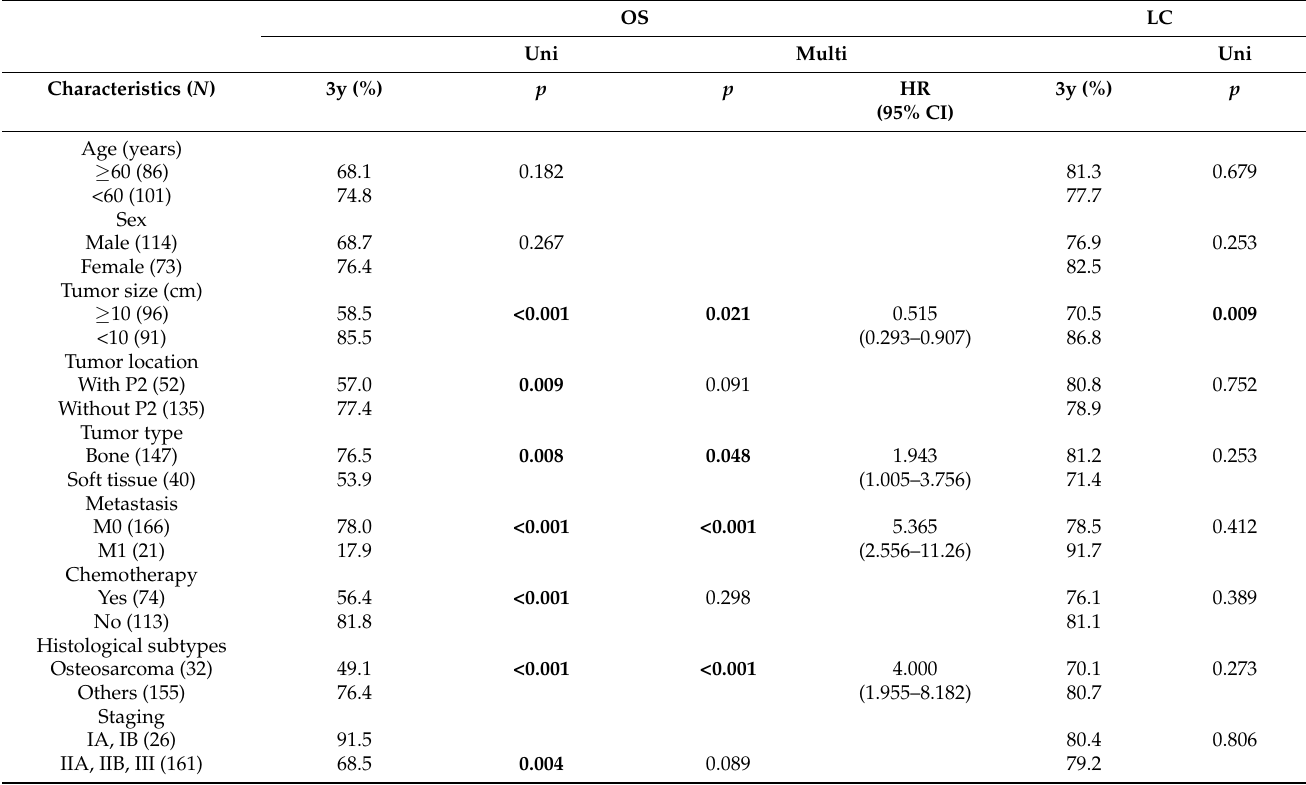
Table 4. Univariate and multivariate analyses for OS and LC.